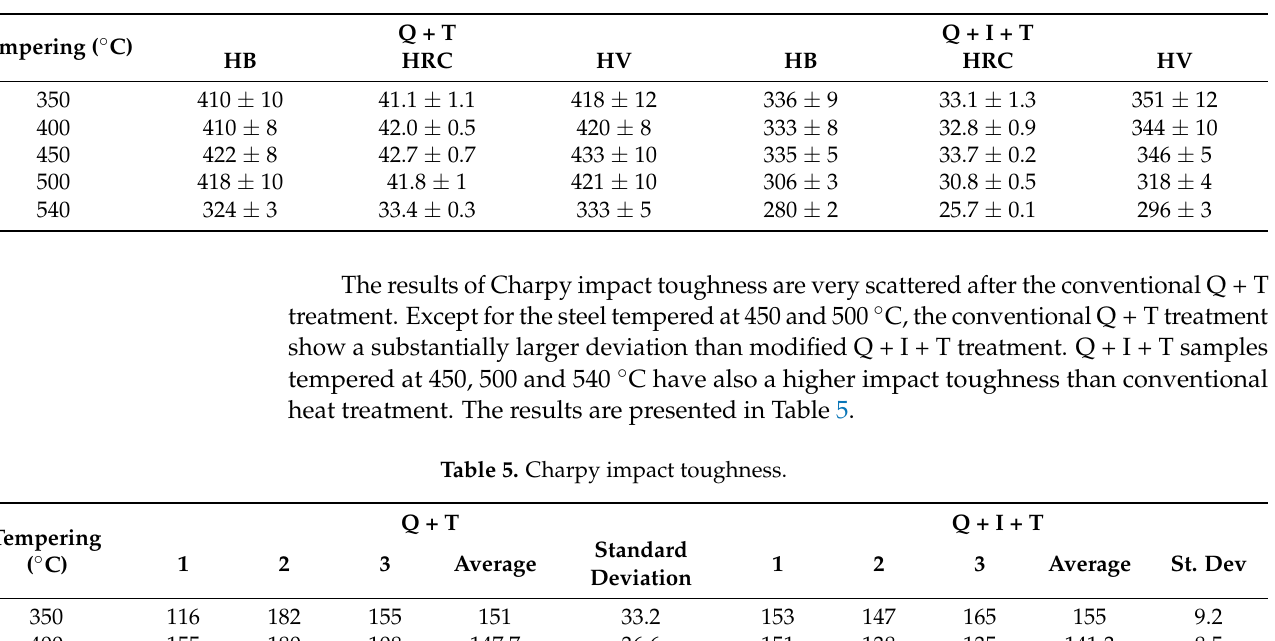
Table 4. Hardness measurements.